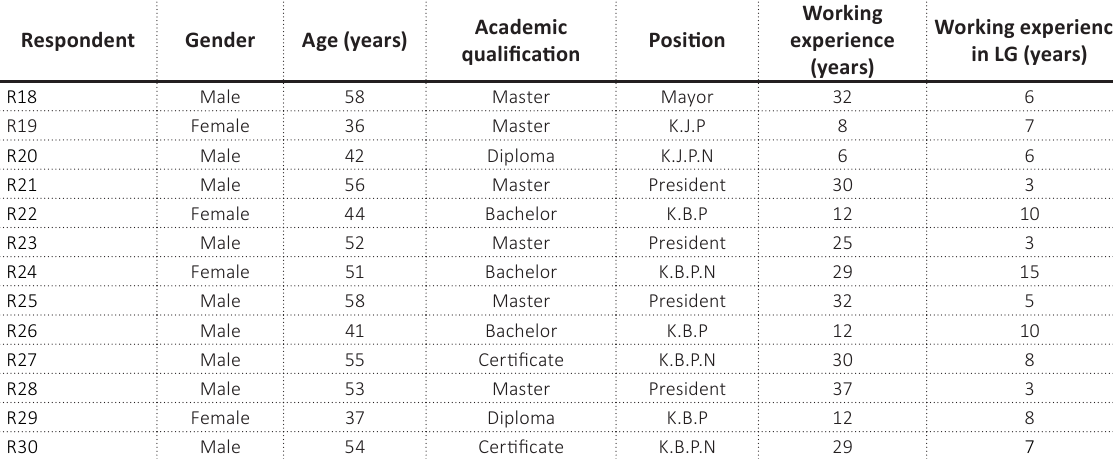
Note: PMR, SRP, and SPM are national examinations in secondary school. Table 2. List of respondents’ profiles among LG